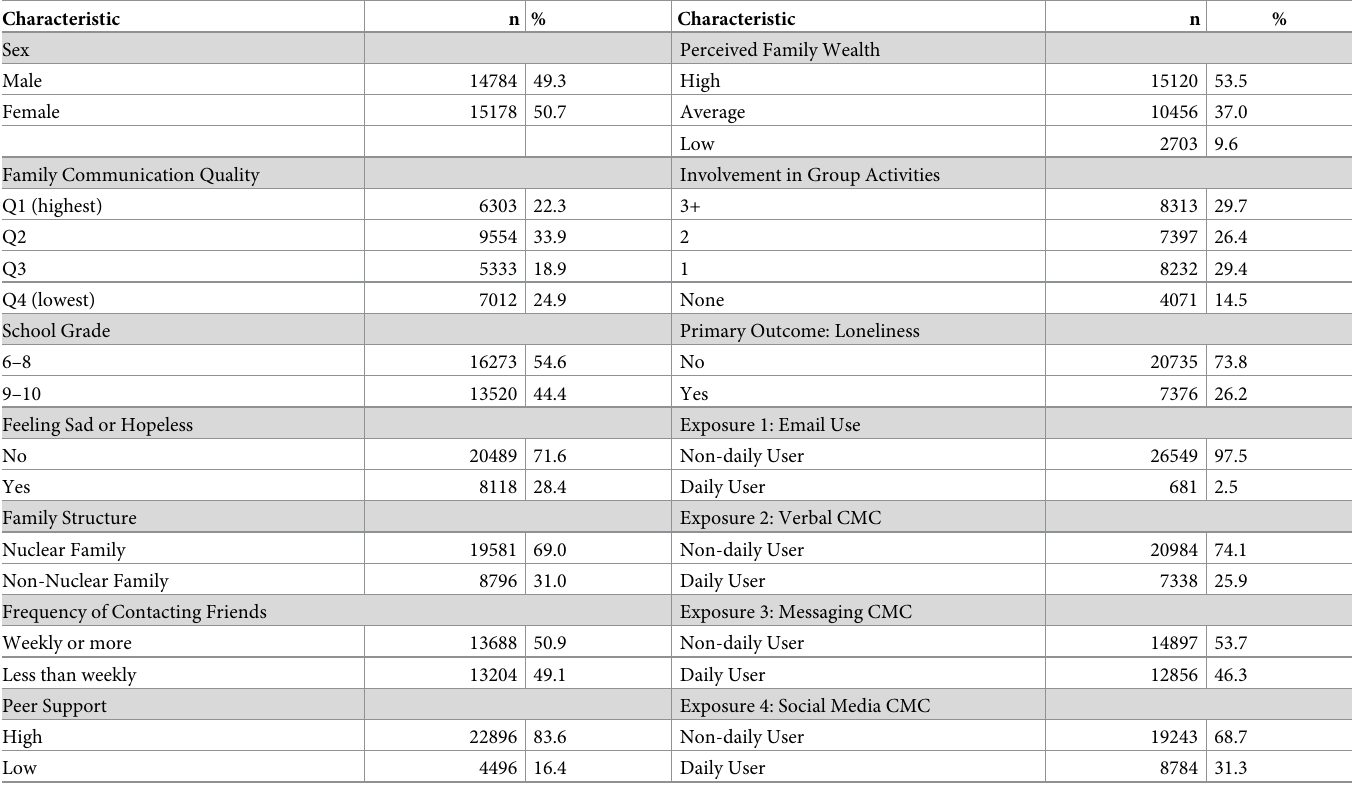
Table 1. Description of the Canadian sample population in the 2013–2014 HBSC study a (N = 30117). Characteristic n %